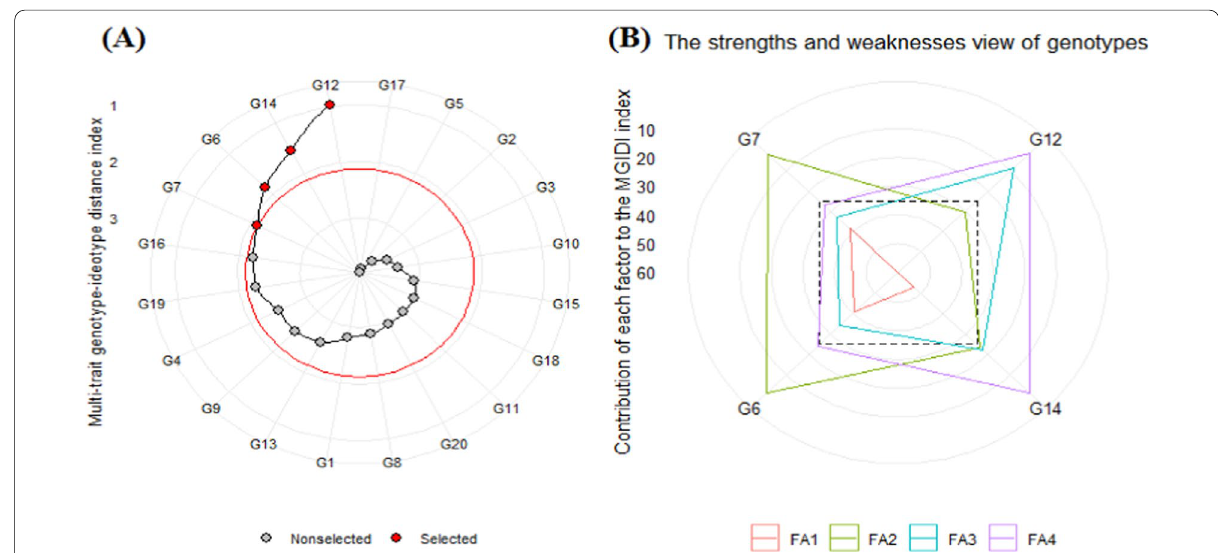
Fig. 3 A Genotype ranking in ascending order for the MGIDI index. The selected genotypes based on this index are shown in red. The central red circle represents the cutpoint according to the selection pressure. B The strengths and weaknesses view of the selected genotypes, shown as the proportion of each factor on the computed MGIDI index. Smaller proportions explained by a factor (closer to the external edge) indicate that the trait within that factor are closer to the ideotype . The dashed line indicates the theoretical value if all the factors had contributed